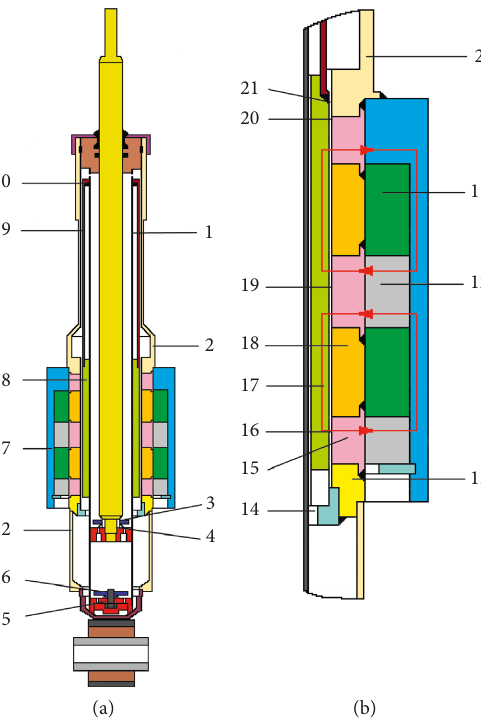
Figure 17: Schematic of MR damper with an inner bypass. 1, rebound chamber; 2, compression chamber; 3, accumulator; 4, connector; 5, piston; 6, piston rod; 7, MRF flow gap; 8, magnetic flux line; 9, electromagnetic coil winding; 10, bobbin (inner tube); 11, outer tube [63,